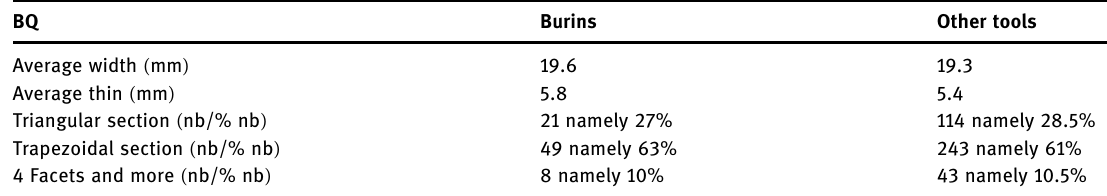
Table 3: Dimensions and characteristics of the section of the blanks selected to make burins and other kind of tools BQ Average width ( mm